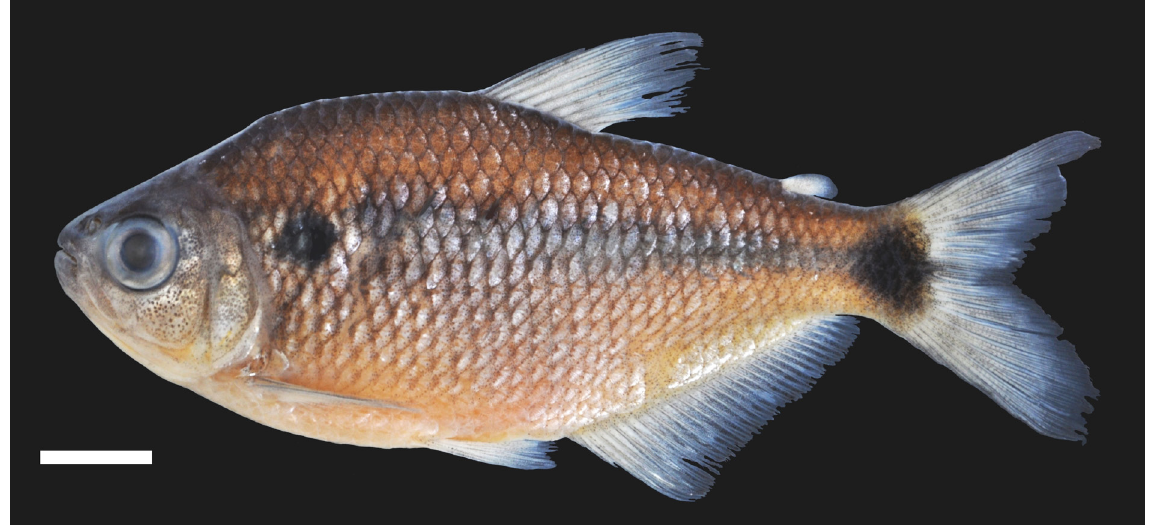
Fig. 2. Astyanax embera sp. nov., holotype, 83.0 mm SL, Telembí River at mouth of Yamunde River, 1 km below Barbacoas, Municipality of Barbacoas, Nariño, Pacific coast of Colombia (IUQ 3614). Scale bar = 1